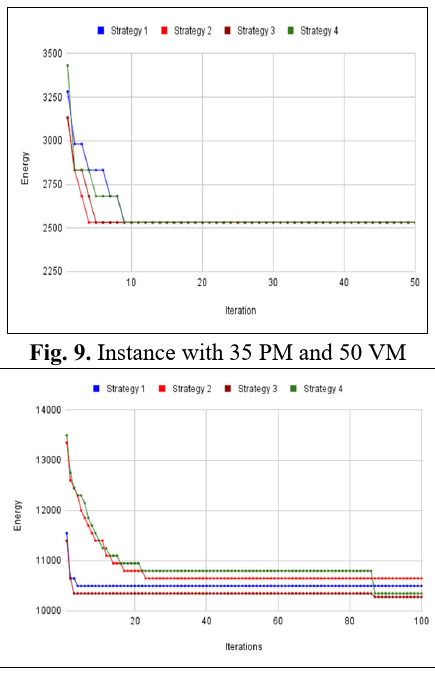
Fig. 11. Instance with 100 PM and 200 VM Fig. 12. Instance with 200 PM and 300